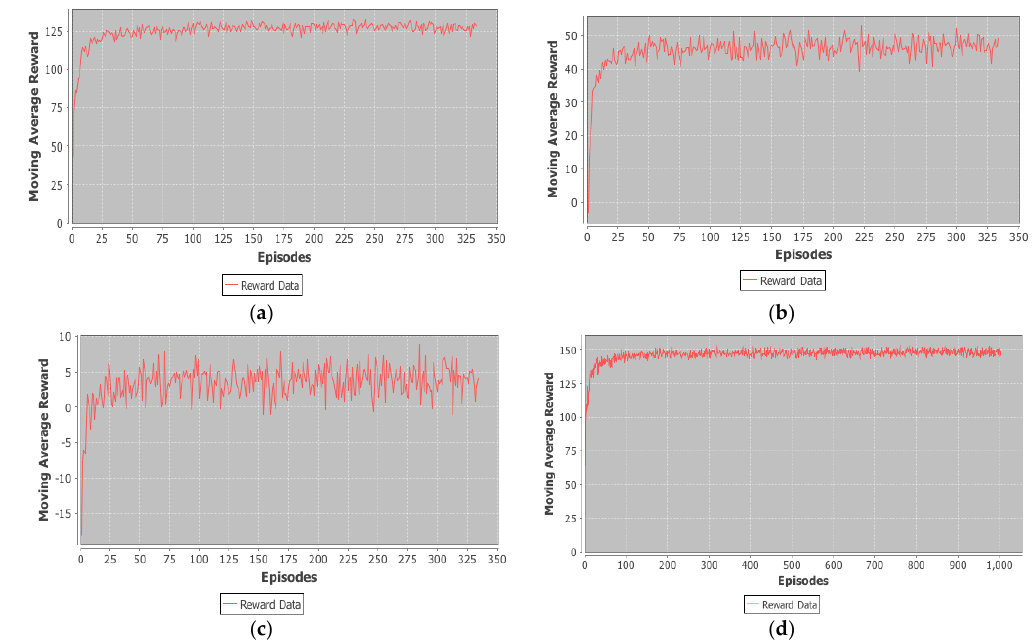
Figure 13. Simulation results. ( a ) Q-learning: plot of the moving average of the 300 average rewards per episode for 100,000 trials with ε-greedy policy for exploration and exploitation ε = 0.2, learning rate α = 0.2 and discount factor γ = 0.2; ( b ) Q-learning: plot of the moving average of the 300 average rewards per episode for 100,000 trials with ε-greedy policy for exploration and exploitation ε = 0.6, learning rate α = 0.2 and discount factor γ = 0.2; ( c ) Q-learning: plot of the moving average of the 300 average rewards per episode for 100,000 trials with ε-greedy policy for exploration and exploitation ε = 0.8, learning rate α = 0.2 and discount factor γ = 0.2; ( d ) State-Action-Reward-State-Action (SARSA)-learning: plot of the moving average of the 300 average rewards per episode for 300,000 trials, learning rate α = 0.2, lambda λ = 0.4 and discount factor γ = 0.2.